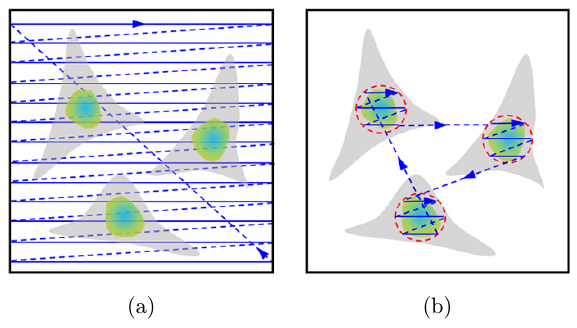
Fig. 3. Comparison of (a) raster scanning with galvanometer scanner and (b) addressable scanning with AOD. If the ROIs (e.g., cell nuclei in the illustration) are discrete, the multiple- ROI scanning will save much of the acquisition